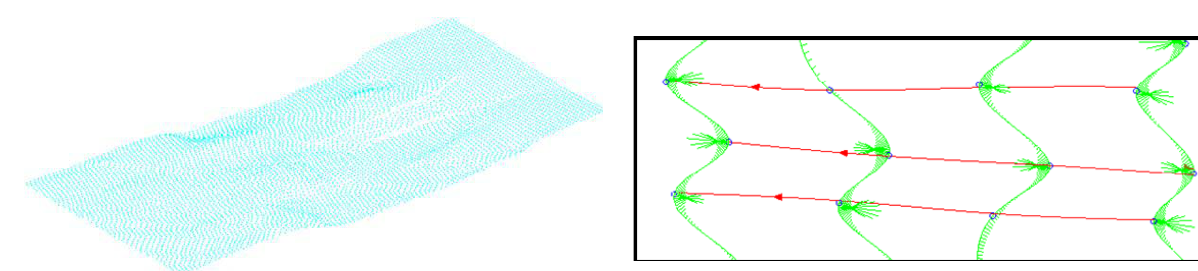
Figure 5: Demo figure of fitting